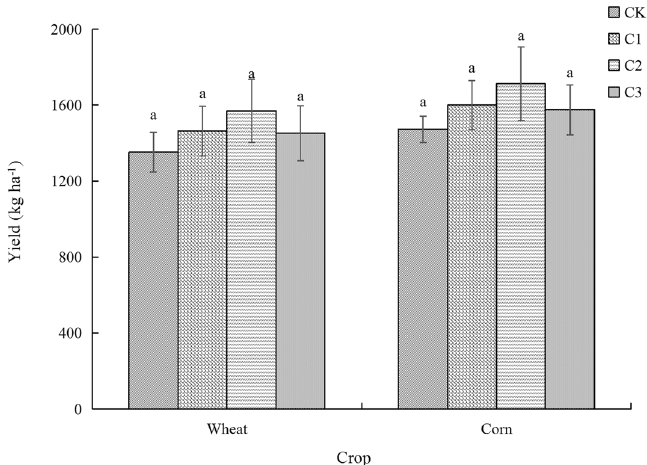
Figure 4. Crop yield in the soft rock:sand compound soil. CK, the volume ratio of soft rock to sand is 0:1; C1, the volume ratio of soft rock to sand is 1:5; C2, the volume ratio of soft rock to sand is 1:2; C3, the volume ratio of soft rock to sand is 1:1. TOC soil total organic carbon; POC particulate organic carbon; DOC dissolved organic carbon; ROC oxidized organic carbon; SMBC soil microbial biomass carbon. The lowercase letters in the figure indicate significant differences between the different treatments at the 5%